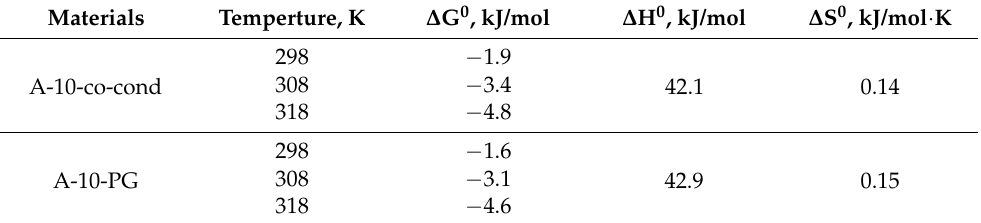
Figure 12. The ln K d versus 1/ T plots for the A-10-co-cond ( left ) and A-10-PG ( right ) samples. Table 3. Thermodynamic parameters for the adsorption of Cr(VI) onto materials.